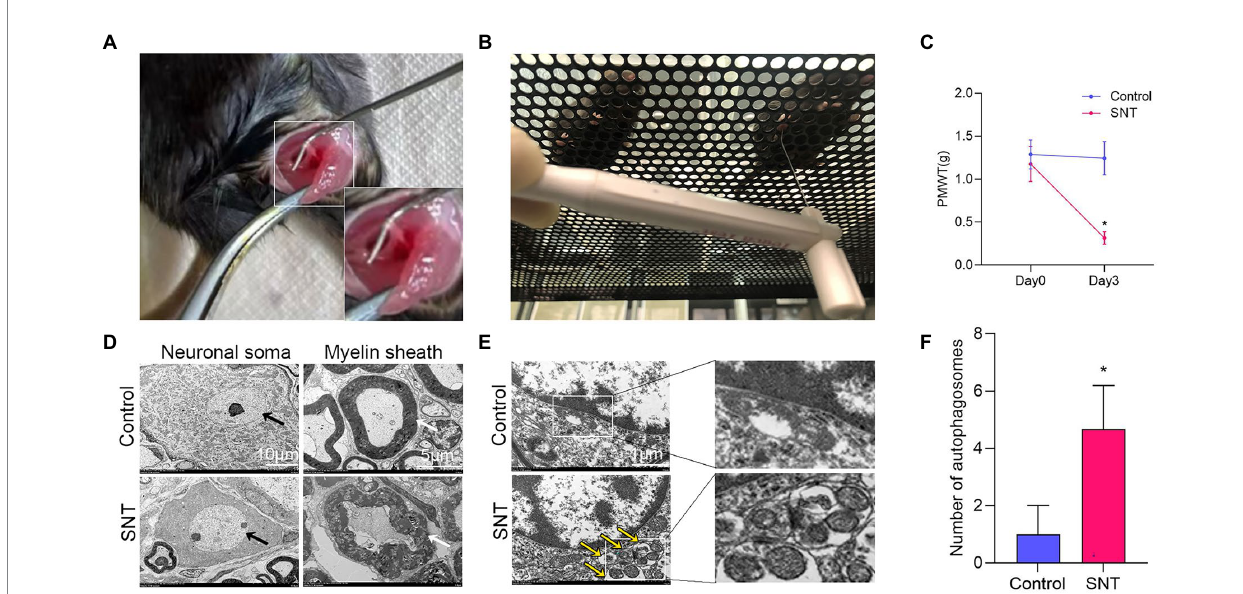
FIGURE 7 Changes of pain threshold and DRG ultrastructure after SNT. (A) The right sciatic nerve of mice was exposed and transected. (B) Behavioral test of mice using Von Frey. (C) SNT induced reduction of PMWT in mice. (D) Electron microscope analysis of the ultrastructural changes in L3/L4 DRGs on the 3rd day after SNT in different groups. The morphology of neuronal somata and myelin sheaths of DRG neurons in two groups. The neuron nucleus is indicated by the black arrow, Scale bar = 10 μ m; magnification ×1,000; The myelin sheath is indicated by the white arrow, Scale bar = 5 μ m; magnification ×2,000. (E) Representative electron microscope views of autophagosomes (yellow arrow) in DRG of the two groups. Scale bar = 1 μ m; magnification ×12,000. (F) The number of autophagosomes of the two groups in per vision was determined on the 3rd day after SNT. Data are presented as means ±SD ( n = 3; * p < 0.05).